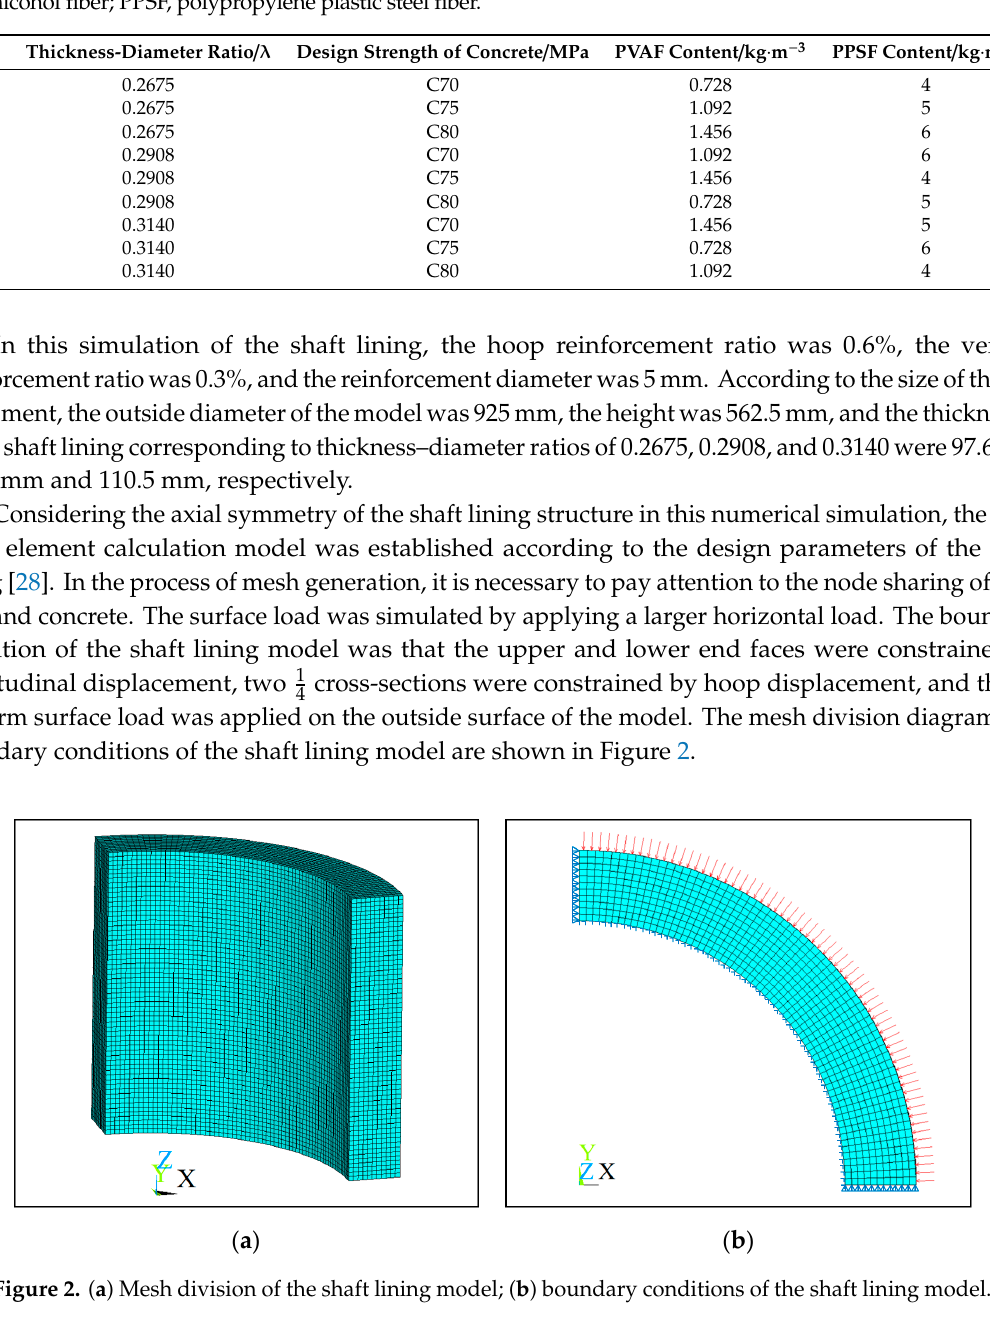
Table 2. Orthogonal design parameters for numerical simulation of shaft lining structures. PVAF, polyvinyl alcohol fiber; PPSF, polypropylene plastic steel fiber.